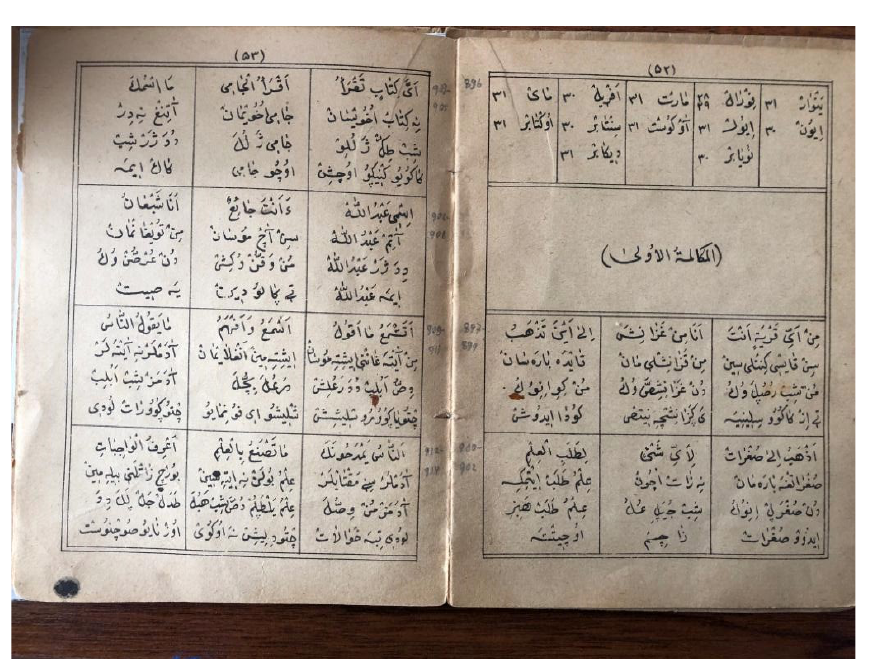
Figure 4 - A simple phrasebook of the “Sullam al-Lisan” Dictionary in four languages: Arabic, Kumyk, Avar and Russian DOI: